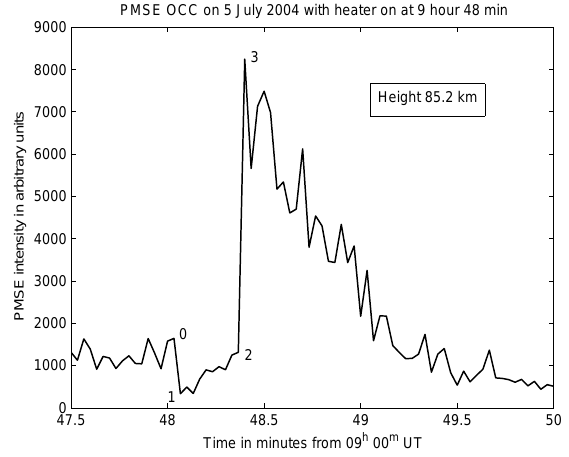
Fig. 3. An example of an observed overshoot characteristic curve (OCC) showing the different phases 0 to 3. The last data point be- fore and the first data point after the heater is switched on is at phase 0 and 1, respectively. The last data point in the heater on phase is 2 and the first data point after the heater is switched off is at 3 af- ter which the dusty plasma and the overshoot relaxes back to their undisturbed value. The observed overshoot shown here, has a shape which is typical for our modelled overshoot